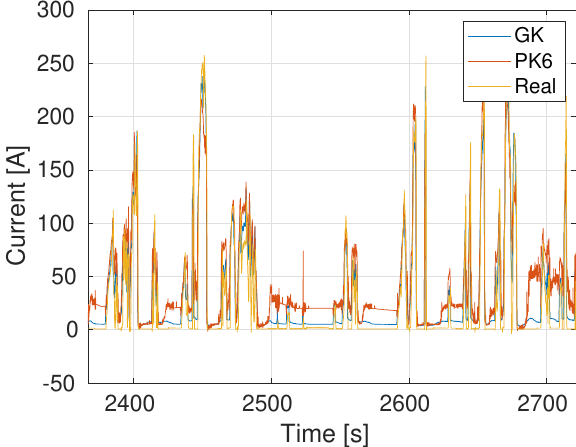
Figure 5. Current prediction: Training using a 15’ sample of Route 1 and Testing on a small portion of Route 2.